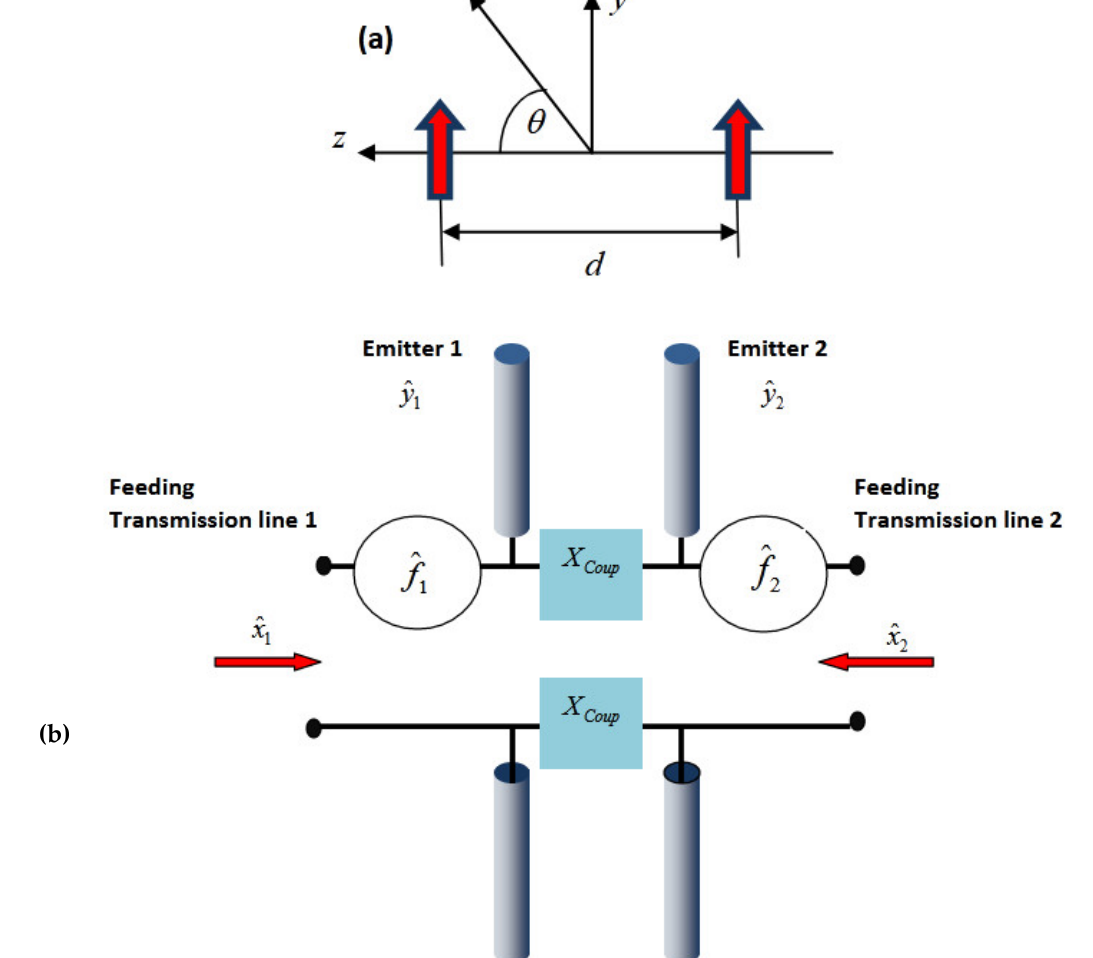
Figure 2. The scheme of a two-element quantum antenna. ( a ) Configuration of antenna: Every emitting element of antenna is an electrical dipole. The dipoles are identical and identically oriented. ( b ) Equivalent electrical circuit of the antenna: The dipoles are fed by the incident field via the corresponding transmission line (operators ˆ x 1,2 ). The feeding is symmetrical (tap is placed at the central point of the dipole). Antenna elements are coupled via reactive impedance X Coup (no thermal losses at the antenna). A part of the incident power is reflected back; another part is distributed between the dipoles and emitted (operators ˆ y 1,2 ). The feeding transmission lines are considered as an external environment. The element coupling produces the special type of noise (operators ˆ f 1,2